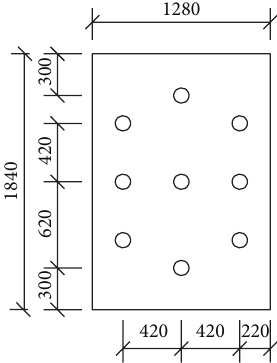
Figure 1: Dimension of the externally insulated wall and location of the thermocouple